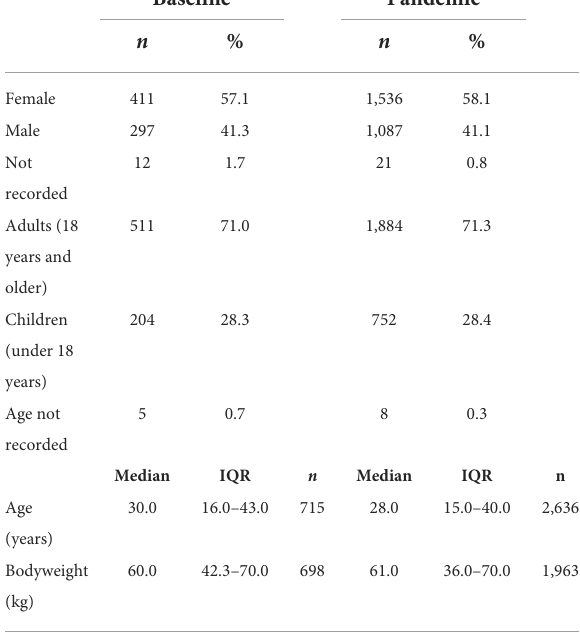
TABLE 1 Patient